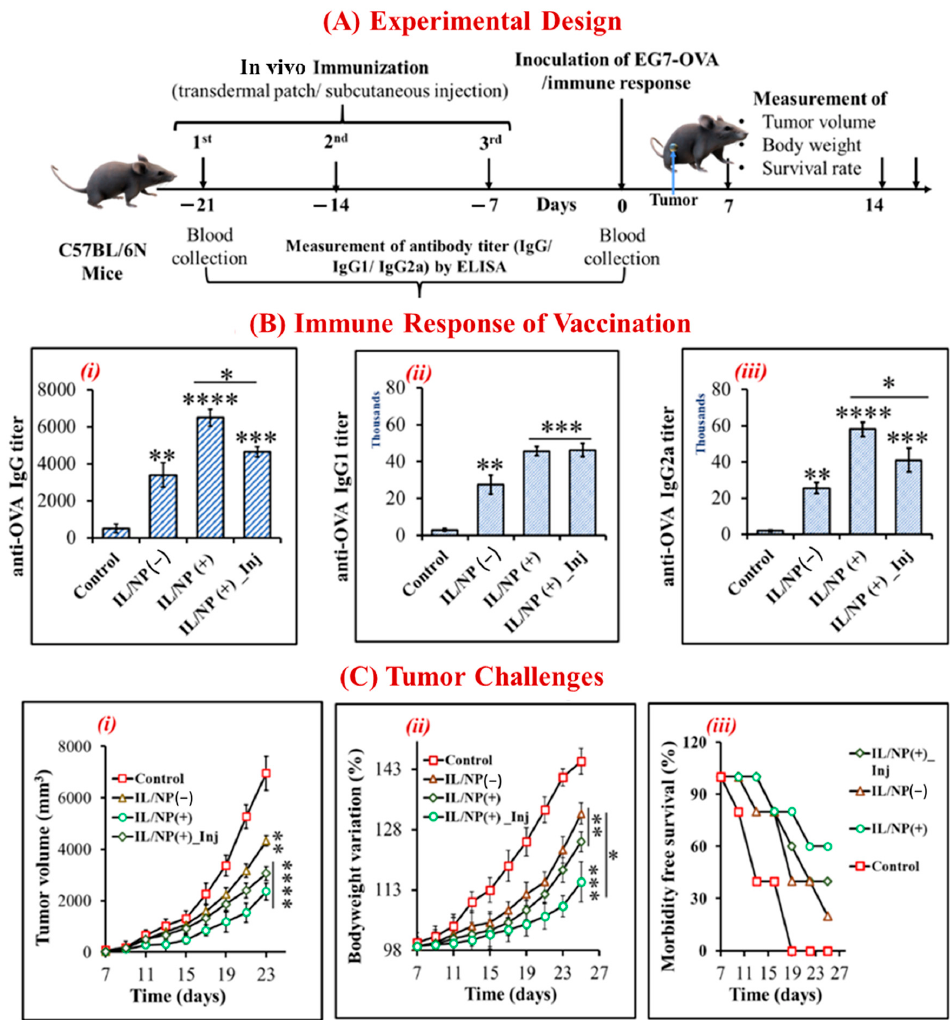
Figure 4. Prophylactic e ff ect of the nanovaccine. ( A ) The experimental approach for vaccination in C57BL/6N mice. ( B ) OVA-speci fi c IgG immune response to nanovaccination: (i) total IgG, (ii) IgG1, and (iii) IgG2a. ( C ) Antitumor e ff ect of the nanovaccine on (i) tumor growth and development, (ii) body weight variation, and (iii) survival. Data are presented as the mean ± SD (n = 5). * p < 0.1, ** p < 0.01, *** p < 0.001, and **** p < 0.0001.